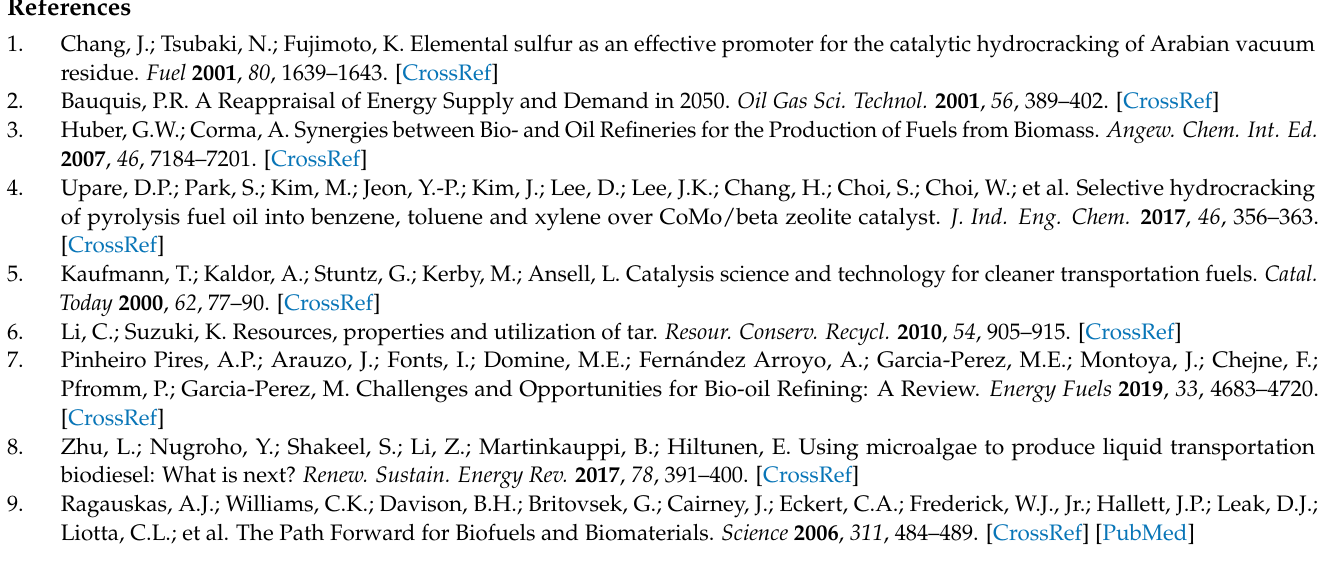
Pd/TiO 2 nano (6–12 nm), Figure S4: Conversion vs. time for Pd/TiO 2 nano catalysts with different Pd loadings, Figure S5: Conversion and TON (mols prod./mols of Pd in solid) vs. Pd loading for Pd/TiO 2 nano catalysts, Figure S6: Selectivity to the different groups of products for Pd/TiO 2 nano catalysts compared in the range 63–65% conversion, Figure S7: XRD patterns of different (a) pure TiO 2 supports and (b) TiO 2 -supported Pd catalysts (Inset showing a zoom of 20-60 2Q region for Pd/TiO 2 nano and Pd/TiO 2 P25), Figure S8: Conversion vs. time for different TiO 2 -supported Pd catalysts in tars mild hydrotreatment, Figure S9: NH 3 -TPD profiles for different TiO 2 -supported Pd catalysts, Figure S10: H 2 -TPR profiles for different TiO 2 -supported Pd catalysts, Figure S11: Selectivity to the different groups of products (compared at ≈ 53% conversion) for 1.3 wt% Pd/TiO 2 nano catalyst by using different H 2 pressures, Figure S12: Catalyst loading optimization in tars mild hydrotreatment over 1.3 wt% Pd/TiO 2 nano, Figure S13: Pd particle size distribution of fresh, reused and regenerated samples of Pd/TiO 2 nano catalyst, Figure S14: SEM-EDX for the fresh sample of Pd/TiO 2 nano catalyst, Figure S15: Nitrogen adsorption-desorption isotherms for different TiO 2 materials, Figure S16: Nitrogen adsorption-desorption isotherms for different metal oxides materials, Table S1: Catalytic activity (Conversion and selectivity to the different groups of products) of carbon-supported Pd, Pt and Ru commercial catalysts (comparison at 50–60% of conversion), Table S2: Pd/TiO 2 nano catalysts prepared by using different Pd precursors and their catalytic results in tars mild